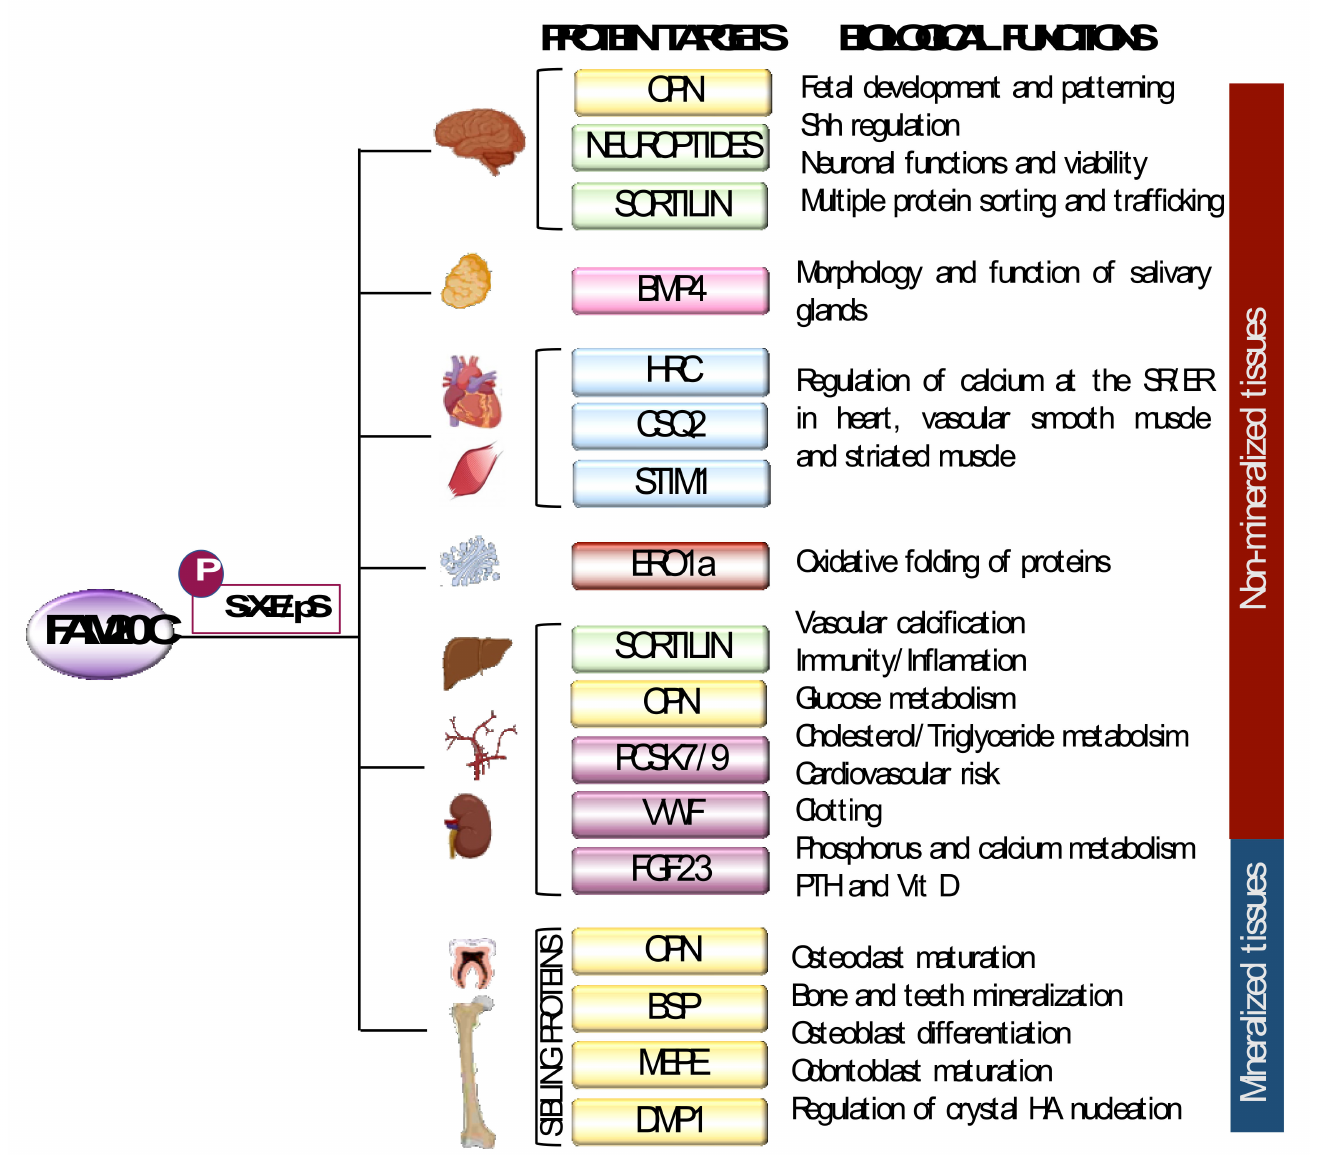
Figure 2. Fam20C classic and novel targets. Picture showing different protein targets of FAM20C and their functions. Classical FAM20C targets with function in mineralization are shown in yellow at the bottom and new described targets are in different colors in the other sections. SR/ER, sarcoplasmic reticulum/endoplasmic reticulum; Vit D, vitamin D; PTH, parathyroid hormone; HA: